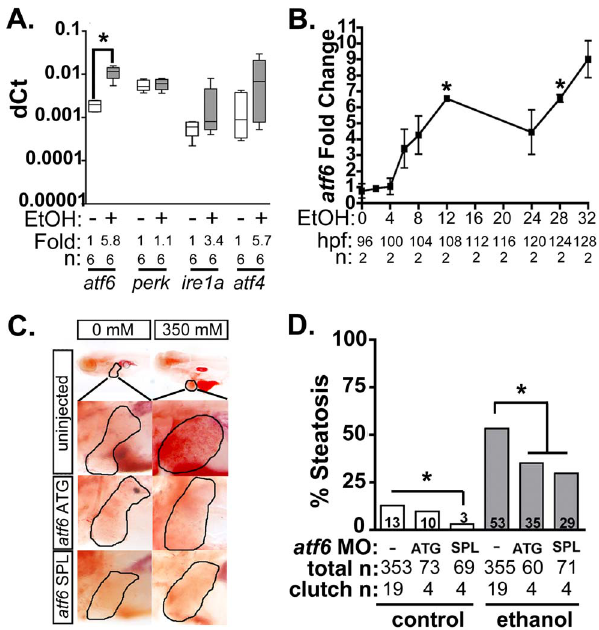
Figure 1. Atf6 is required for alcoholic steatosis. A: qPCR analysis of UPR sensors atf6, perk, ire1a, and atf4 in the livers of control (EtOH-) and 350 mM ethanol-treated (EtOH + ) larvae. dCt values were calculated by normalization to rpp0. Fold changes were calculated based on median dCt values. Statistics: paired t-test. *, p , 0.05. B: Expression of atf6 in the livers of 350 mM ethanol treated larvae from 0–32 hours. Fold changes were determined by normalizing to control (0 mM EtOH) dCt values. Statistics: one-sample t-test. *, p , 0.05. C: Images of oil red O stained whole larvae injected with two different morpholinos targeting atf6 (ATG-targeting, atf6 ATG, and splice-blocking, atf6 SPL) and exposed to either 0 or 350 mM ethanol. Livers are circled in the enlarged boxes. D: Steatosis incidence based on scoring oil red O stained larvae at 5.5 dpf. Statistics: chi-square with Fisher’s Exact Test. *, p , 0.05. ‘‘Total n’’ and ‘‘clutch n’’ corresponds to the number of larvae and number of clutches scored.